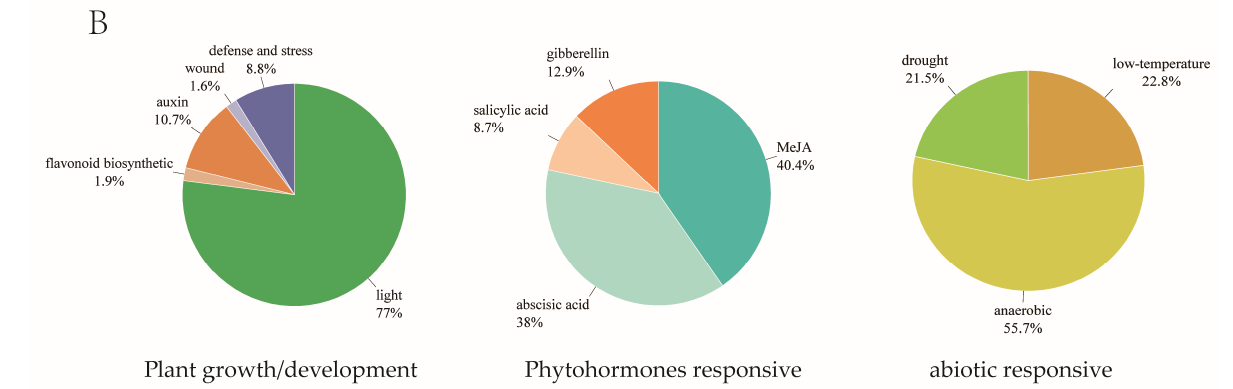
Figure 5. Cis-acting elements in the MYB promoter region of Rhododendron delavayi . ( A ) MYB gene promoter region regulatory elements. Boxes of different colors represent various cis elements and are distributed in different positions among 184 MYB genes. Axes represent gene length. ( B ) Statistics of cis elements in MYB promoter involved in plant growth and development, phytohormone response, and abiotic stress response.